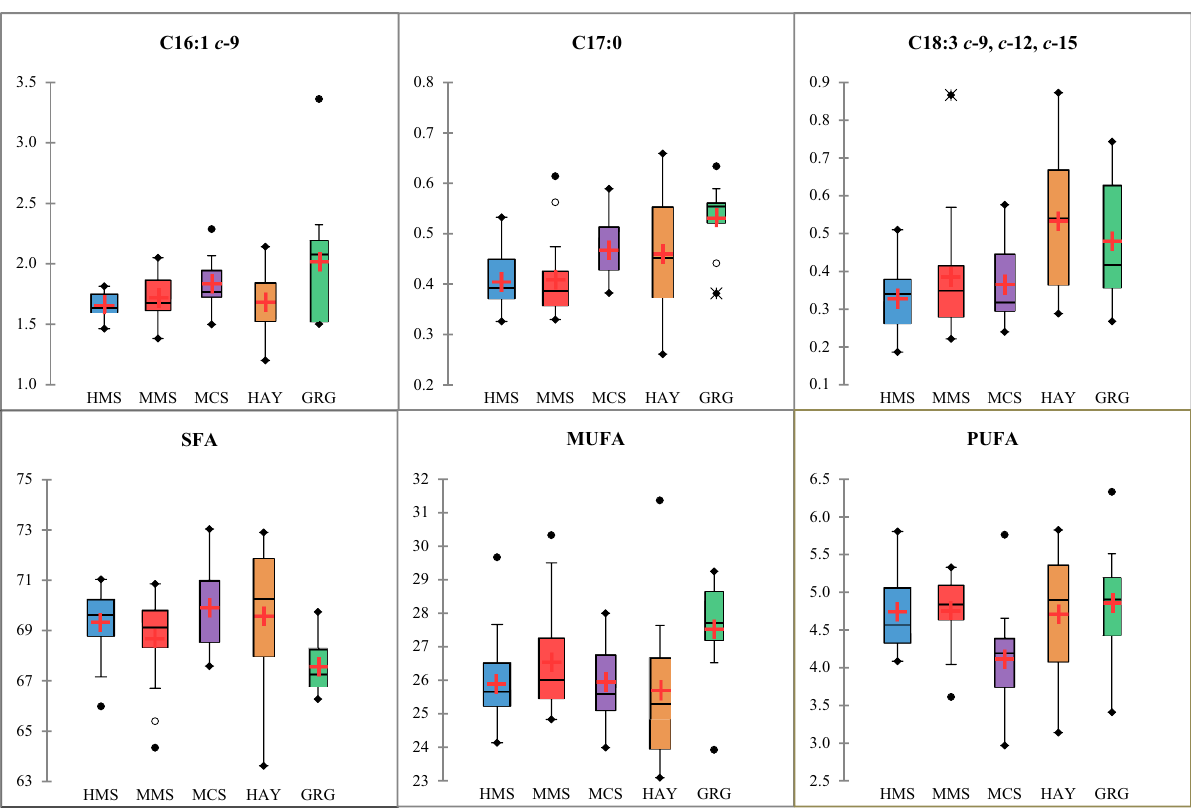
Figure 2. Box–Whisker plots of fatty acids (g/100 g of total fatty acids) according to the five feeding groups. HMS , high maize silage; MMS , medium maize silage; MCS , mixed crop silages; HAY , grass and lucerne hays; GRG , green grass. The box plots represent the following descriptive statistics: median (bar in box), mean ( + , red cross), 25% (Q1) and 75% (Q3) quartile (bottom and top end of the box), minimum [Q1 − 1.5 × (Q3 − Q1)] and maximum [Q1 + 1.5 × (Q3 − Q1)] whiskers (lines outside), minimum and maximum values (•, full black circles), outliers with a distance to box of 1.5–3.0 times interquartile range (°, empty circles) or higher than 3 times interquartile range (*, asterisks). For the fatty acids abbreviations see Table